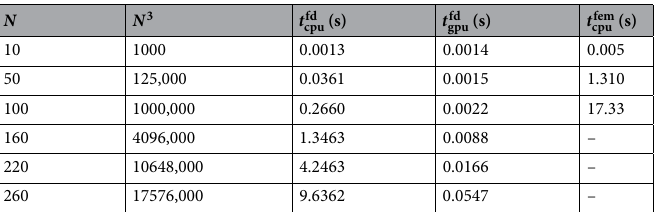
Table 1. Timing comparison for the FFT strayfield calculation on a cubic N × N × N grid. t fd cpu (s) was